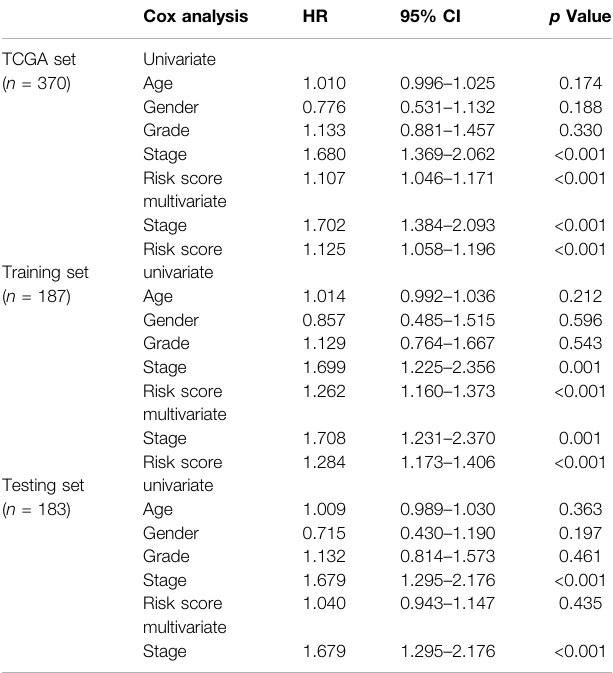
TABLE 2 | Cox regression analyses of clinical variables and GILncSig risk score associated with overall survival in HCC. Cox